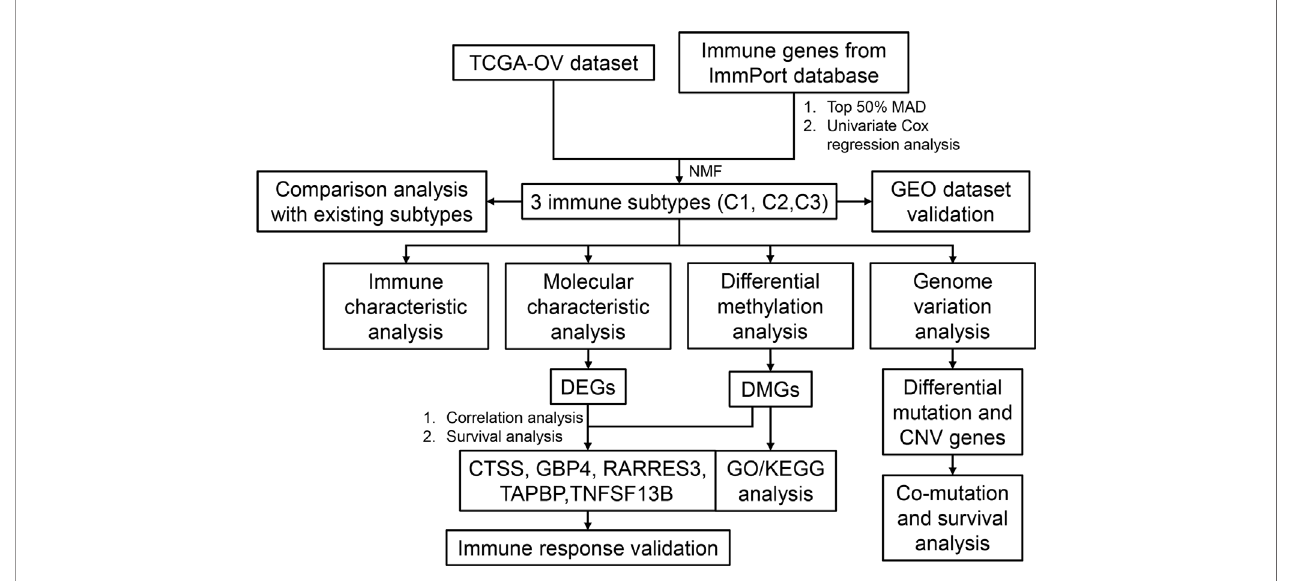
FIGURE 1 | The work fl ow of study